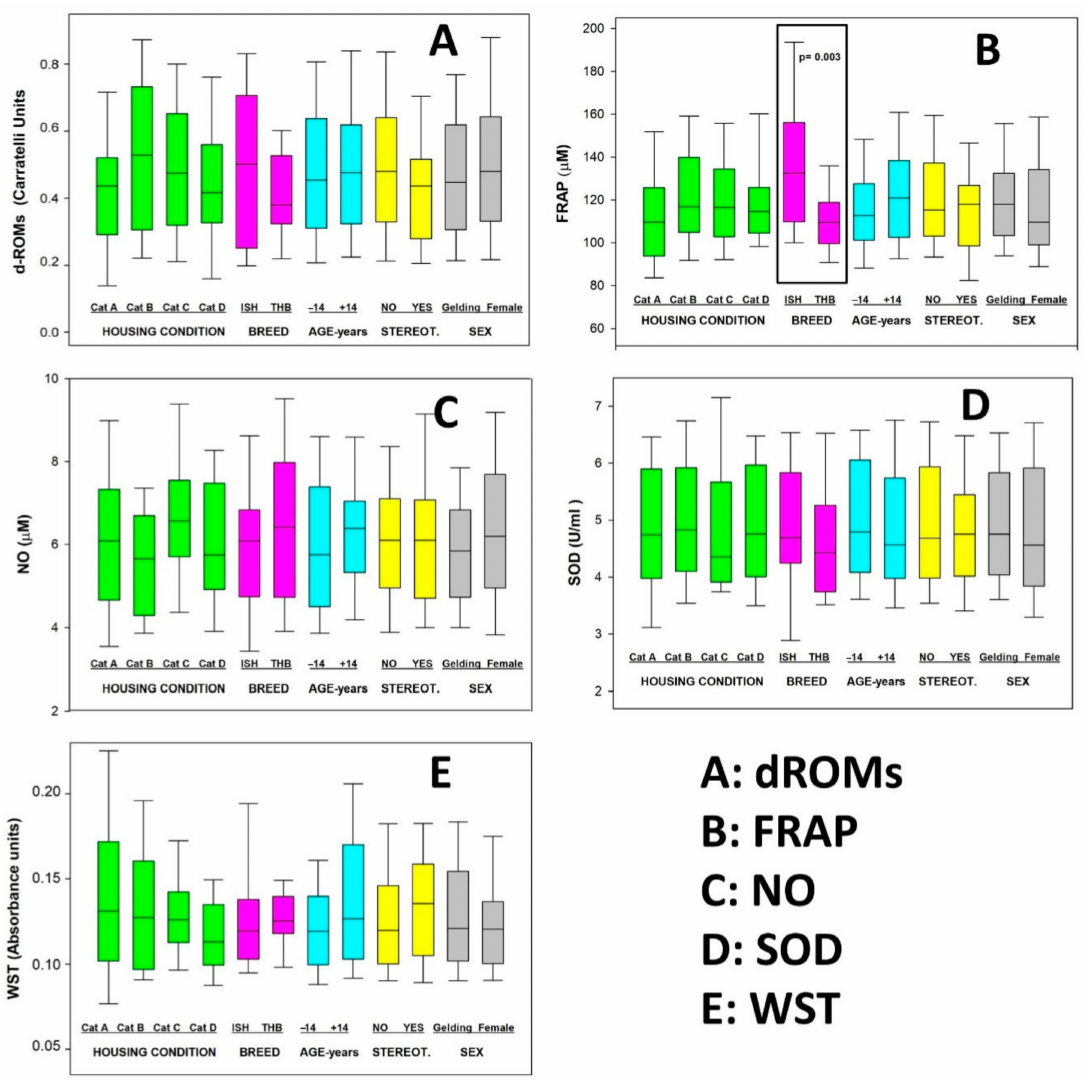
Figure 2. Box plots of the redox markers of the 117 horses enrolled, considering the di ff erent housing conditions (green), breed (pink), age (cyan), stereotypy (yellow) and gender. The data were analyzed by Kruskal–Wallis